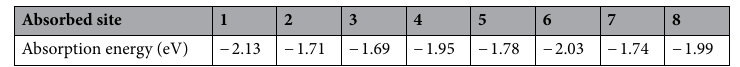
Table 1. The adsorption energy of 2 Si’ atoms on ASiNRs:H surface.